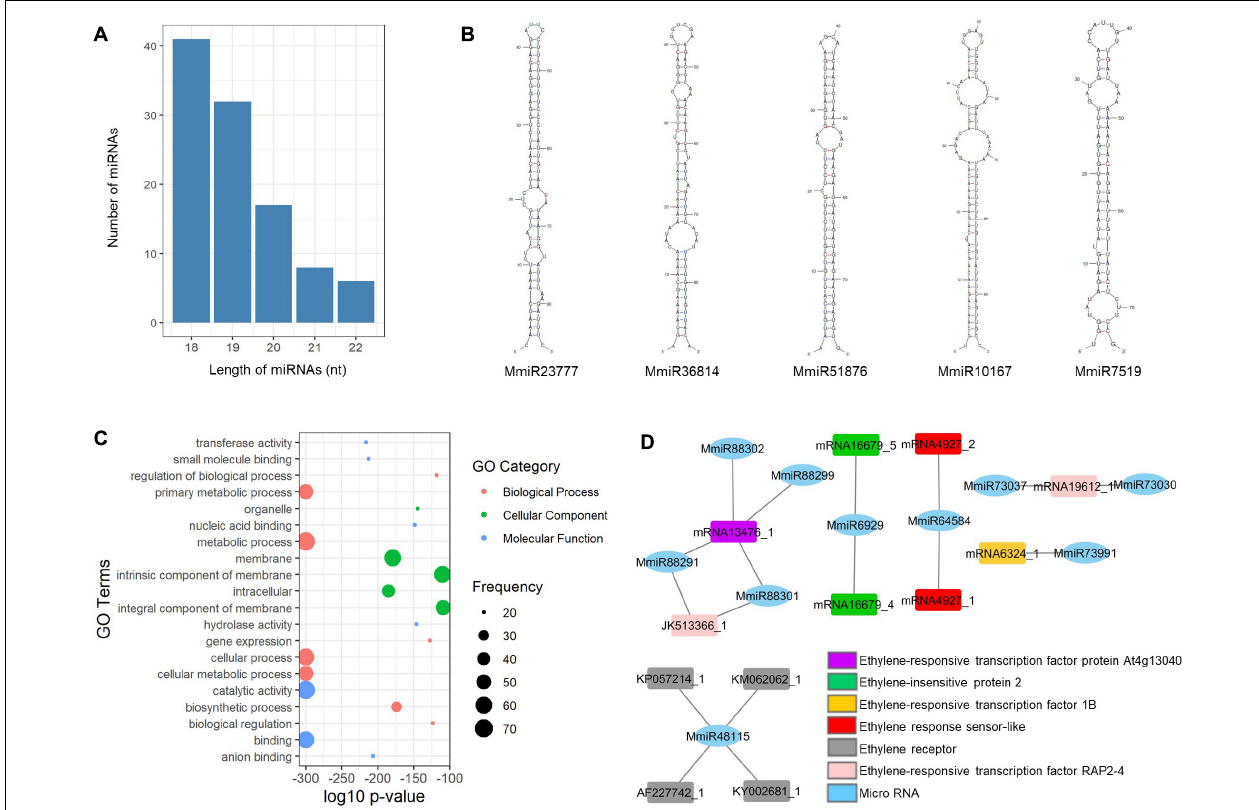
FIGURE 2 | Mango miRNAs. (A) The number and length distribution of miRNAs; (B) hairpin structures of five precursor miRNAs involved in the developmental process of mango; (C) GO enrichment analysis of highly enriched top 20 target genes of miRNAs; (D) interaction among the 10 mango miRNAs and six ethylene-responsive target